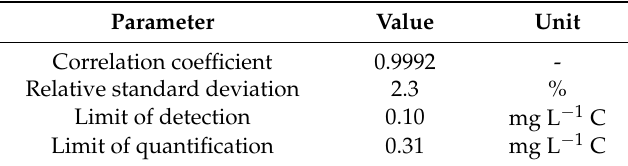
Table 4. Parameters of the validation according to DIN 32 645